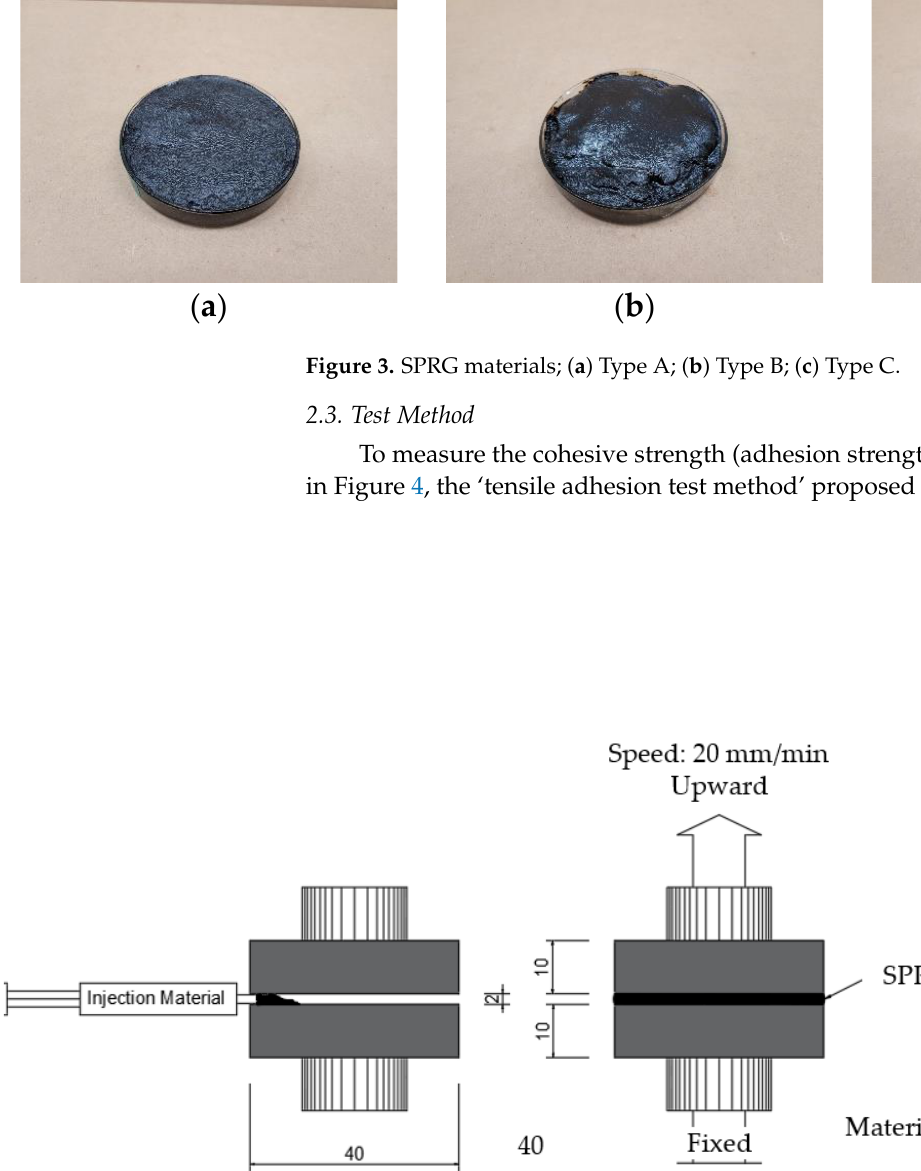
( b ) Figure 5. UTM Testing apparatus; ( a ) UTM, ( b ) apparatus set-up within the UTM for testing. 3. Analysis and Consideration of Result 3.1. Cohesive Strength and Toughness of 2 mm Thickness The results of measuring the cohesive strength and toughness under the temperature conditions of 5 °C, 10 °C, and 20 °C on a 2 mm thick specimen for each SPRG viscosity